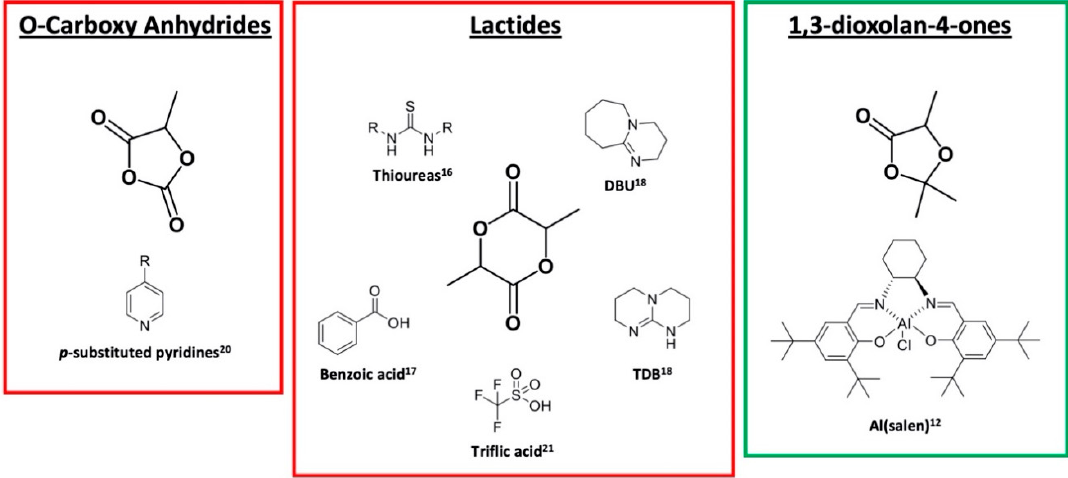
Figure 1. State of the art on organocatalyzed O-carboxy anhydrides (OCAs) and lactide polymerization, compared to metal-catalyzed 1,3-dioxolan-4-one (DOX) polymerization.